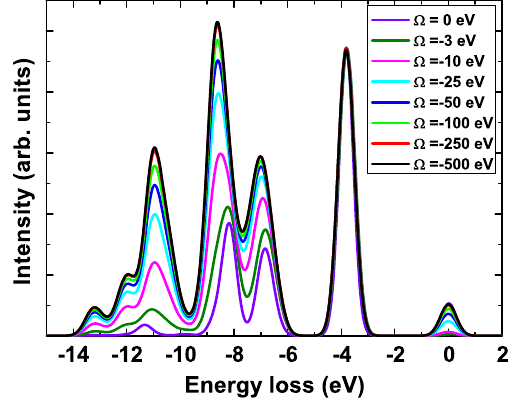
FIG. 7. Calculated S K β RIXS spectra of the CS 2 molecule for different excitation-energy detuning values below the 1 s → 3 π LUMO resonance. The evolution of the electron wave packet is reflected in the Ω dependence of the RIXS profile for the detuning values larger than the energy spacing between the absorption